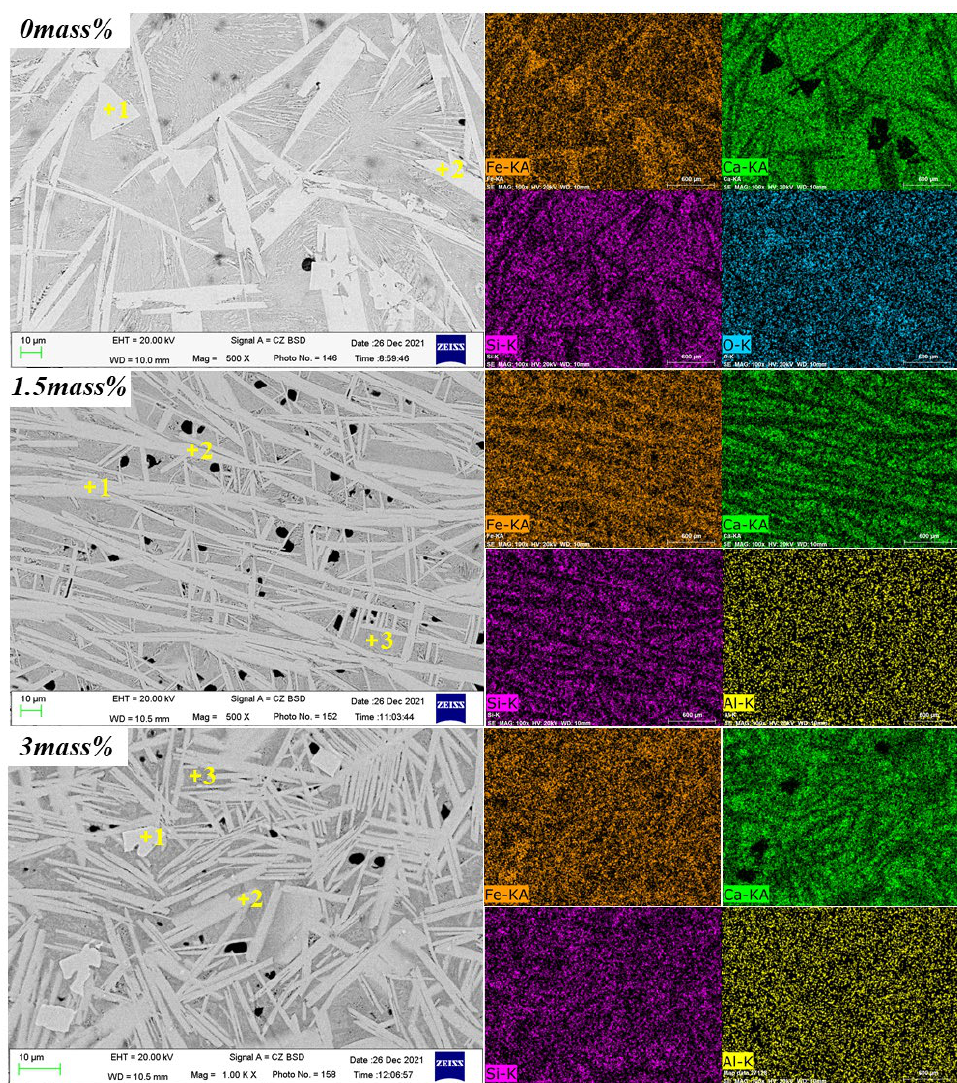
Figure 7. SEM-EDS mapping of the samples, morphology, and distribution of main elements.